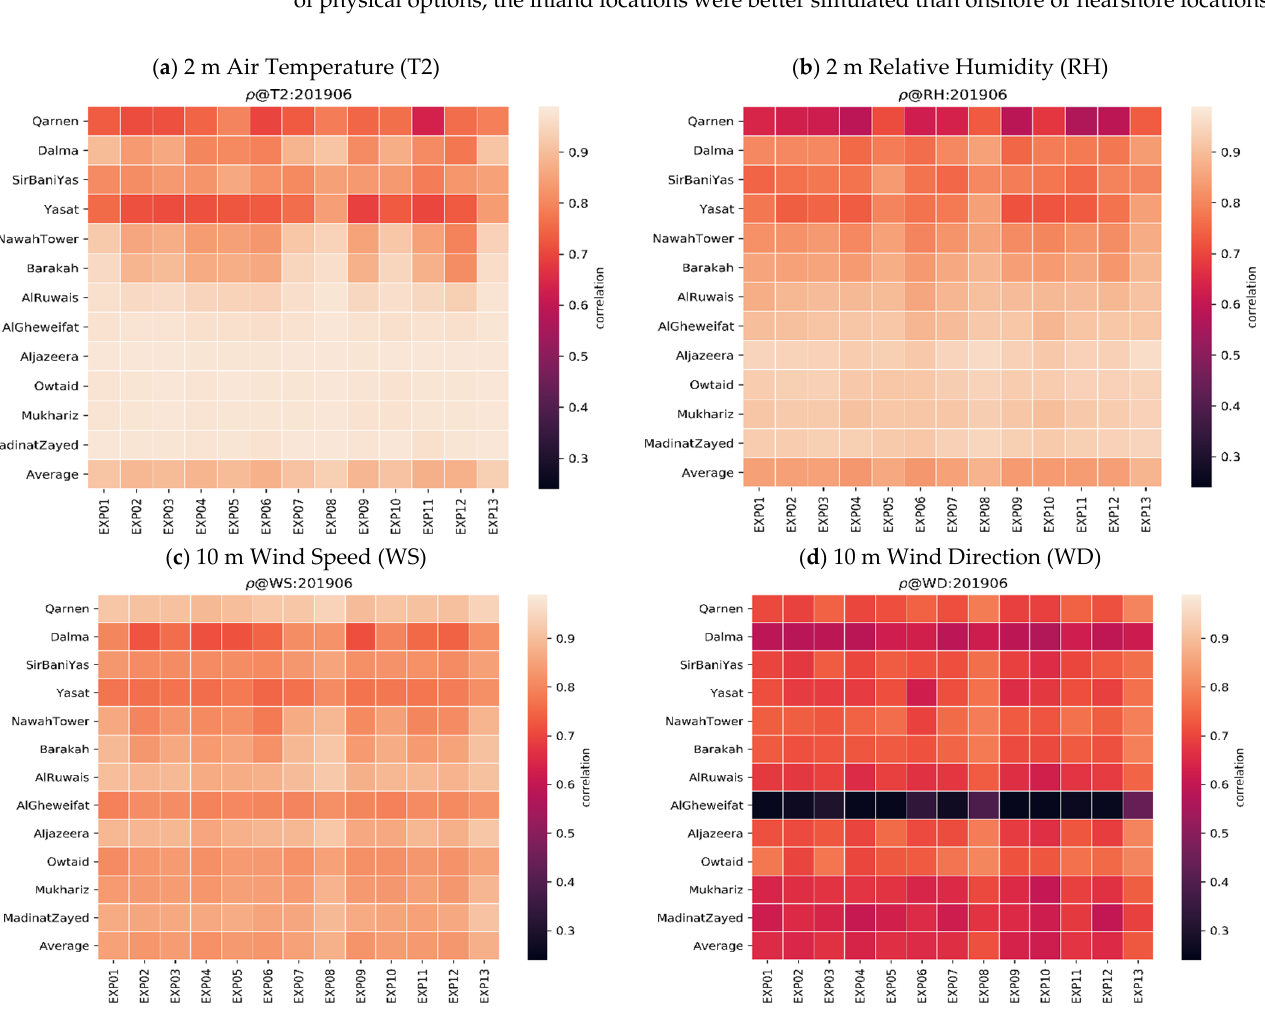
Figure 2. Correlation coefficient ( ρ ) between station data and the conducted model experiments calculated using June 2019 hourly data for the surface parameters 2 m air temperature (T2) and relative humidity (RH2), wind speed (WS), and wind direction (WD) at 10 m above the ground. The last lines of the heatmaps show average values over all stations.